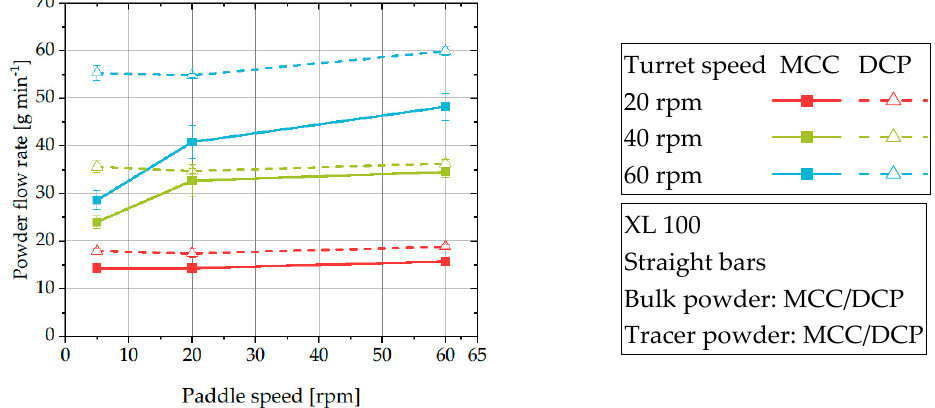
Figure 6. Powder flow rates of DCP and MCC using the XL 100 for three different levels of turret and paddle speed.